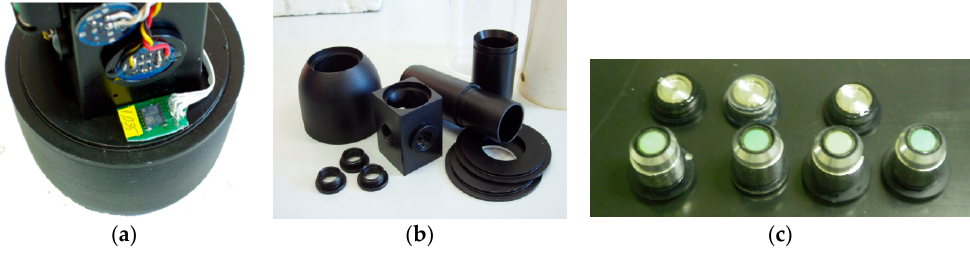
Figure 2. ( a ) The triaxial accelerometer installed on the bottom of the electronics; ( b ) ArLoC modular